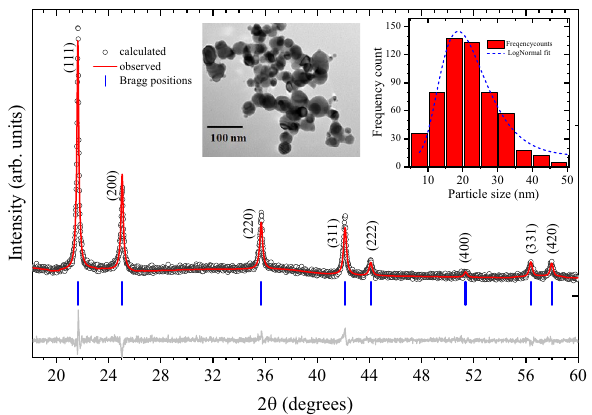
Figure 1. X-ray powder diffraction pattern (XRPD) of the samples at 50 °C, measured with λ = 0.77435 Å; Symbols are measured data, solid redline is the refinement result, grey solid line is the difference pattern and vertical blue bars are the calculated Bragg peak positions. Inset here shows a typical TEM image and nanoparticle size distribution extracted by analyzing several of such